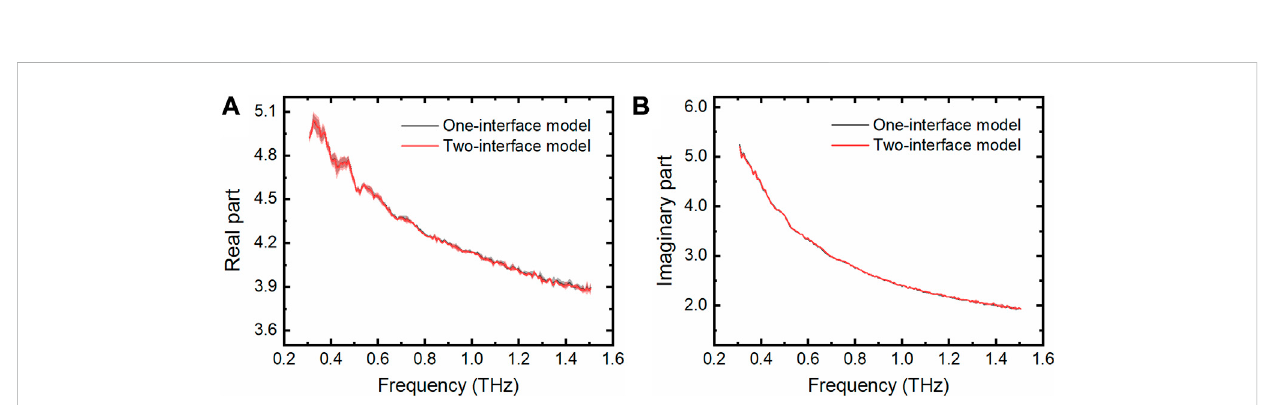
FIGURE 5 THz spectra of PBS measured by the THz TD-ATR micro fl uidic system. Real parts (A) and imaginary parts (B) of the complex dielectric constants of PBS were extracted by employing the one-interface model and the two-interface model, respectively. Translucent areas around each line indicate the standard deviation from three independent